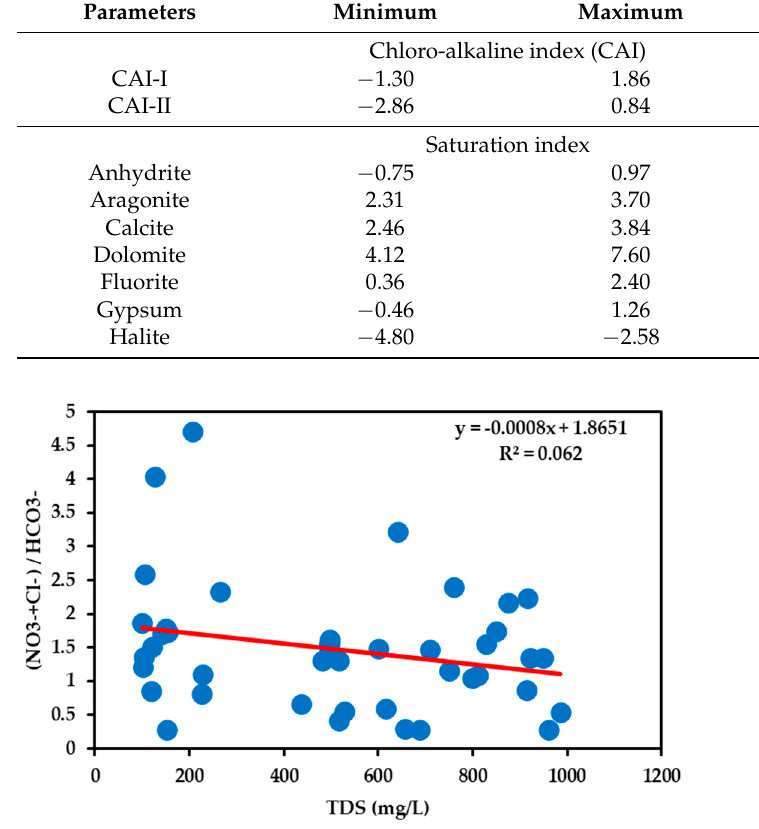
Figure 14. Ion exchange diagram of groundwater samples in study region.